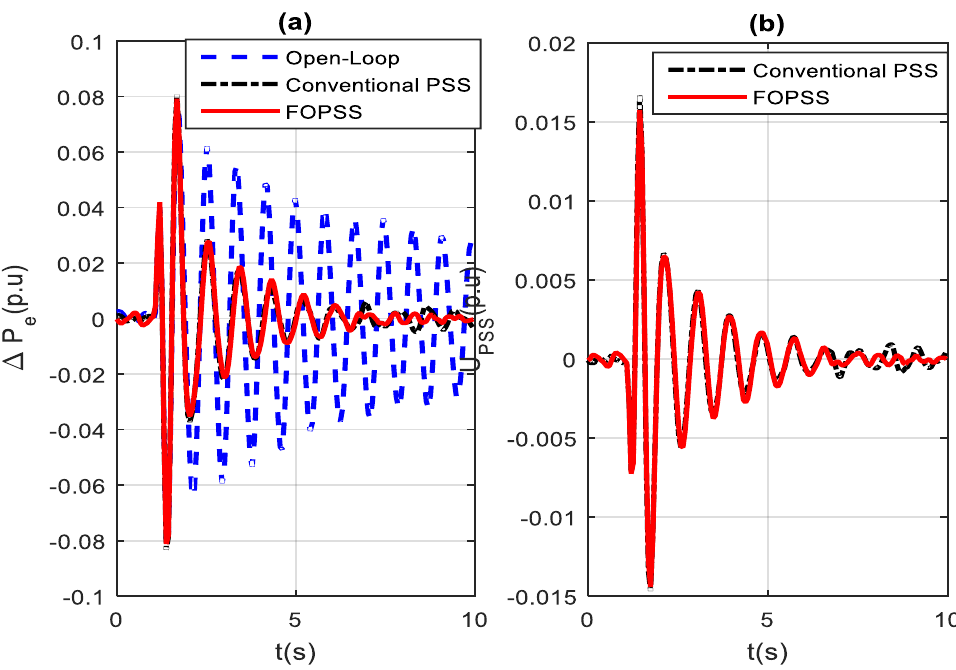
Figure 13. ( a ) Active power deviation response; and ( b ) control effort, at 0.6 p.u. operation point.